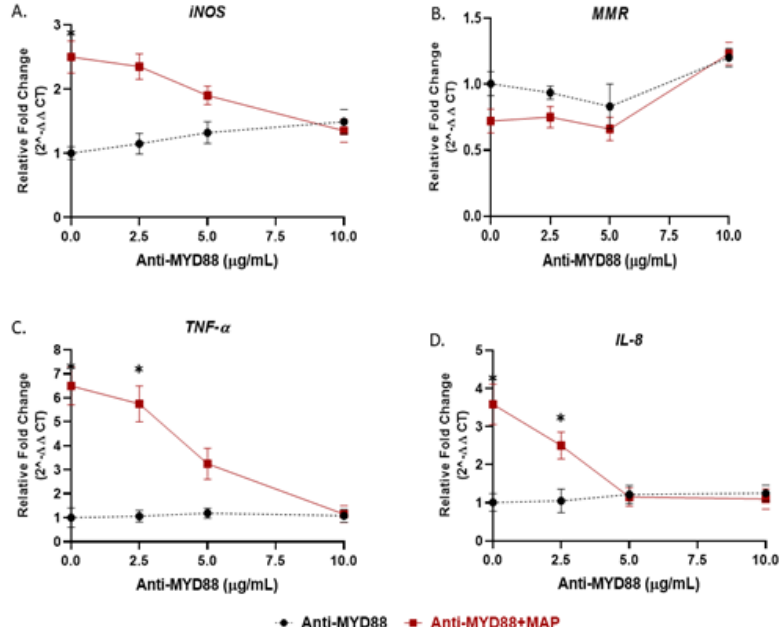
Figure 5. MyD88 antagonist cancels the macrophage response against MAP infection: M1, M2, TNF- α , and IL-8 studies. THP-1 PMA differentiated macrophages were infected with MAP for 24 h after pretreatment with 0, 2.5, 5 and 10 µg/mL of T6167923 (Anti- MyD88 ). Expression of iNOS ( A ), MMR ( B ), TNF-α ( C ) and IL-8 ( D ) were measured by RT-PCR. All experiments were performed in duplicate. * p < 0.05.